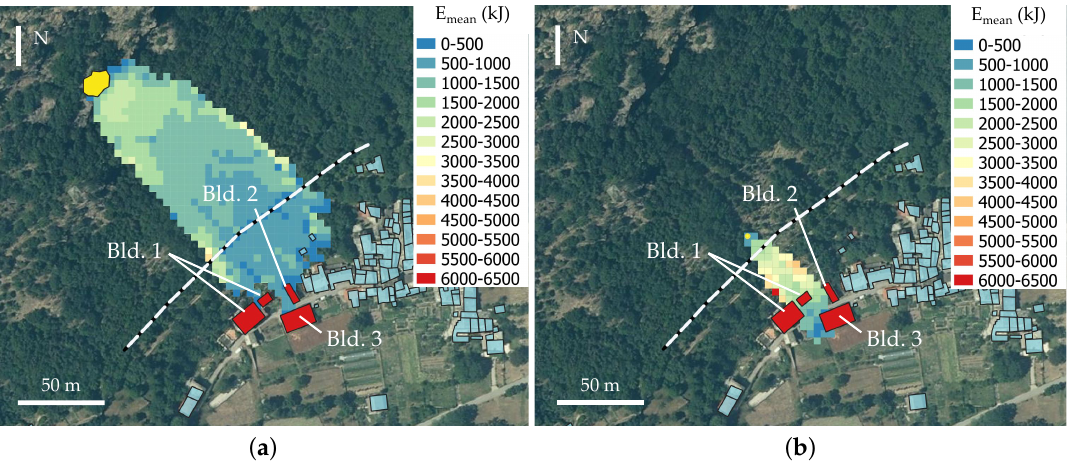
Figure 4. Map of the mean kinetic energy obtained with the software Rockyfor3D for the back-analyses of the November 2011 event in Cels-Morlière (rockfall source zone in yellow, impacted buildings in red, barrier in white dashed line): ( a ) Back-analysis of the main event (i.e., cubic block with volume of 5 m 3 , which represents the average volume estimated for the 2011 event). It can be seen that the intensity of the phenomenon, evaluated at the involved buildings (Bld. 1 to 3) is compatible with the surveyed damage levels; ( b ) back-analysis of the re-mobilization of the 40 m 3 cubic block. The detachment niche is located uphill the barrier